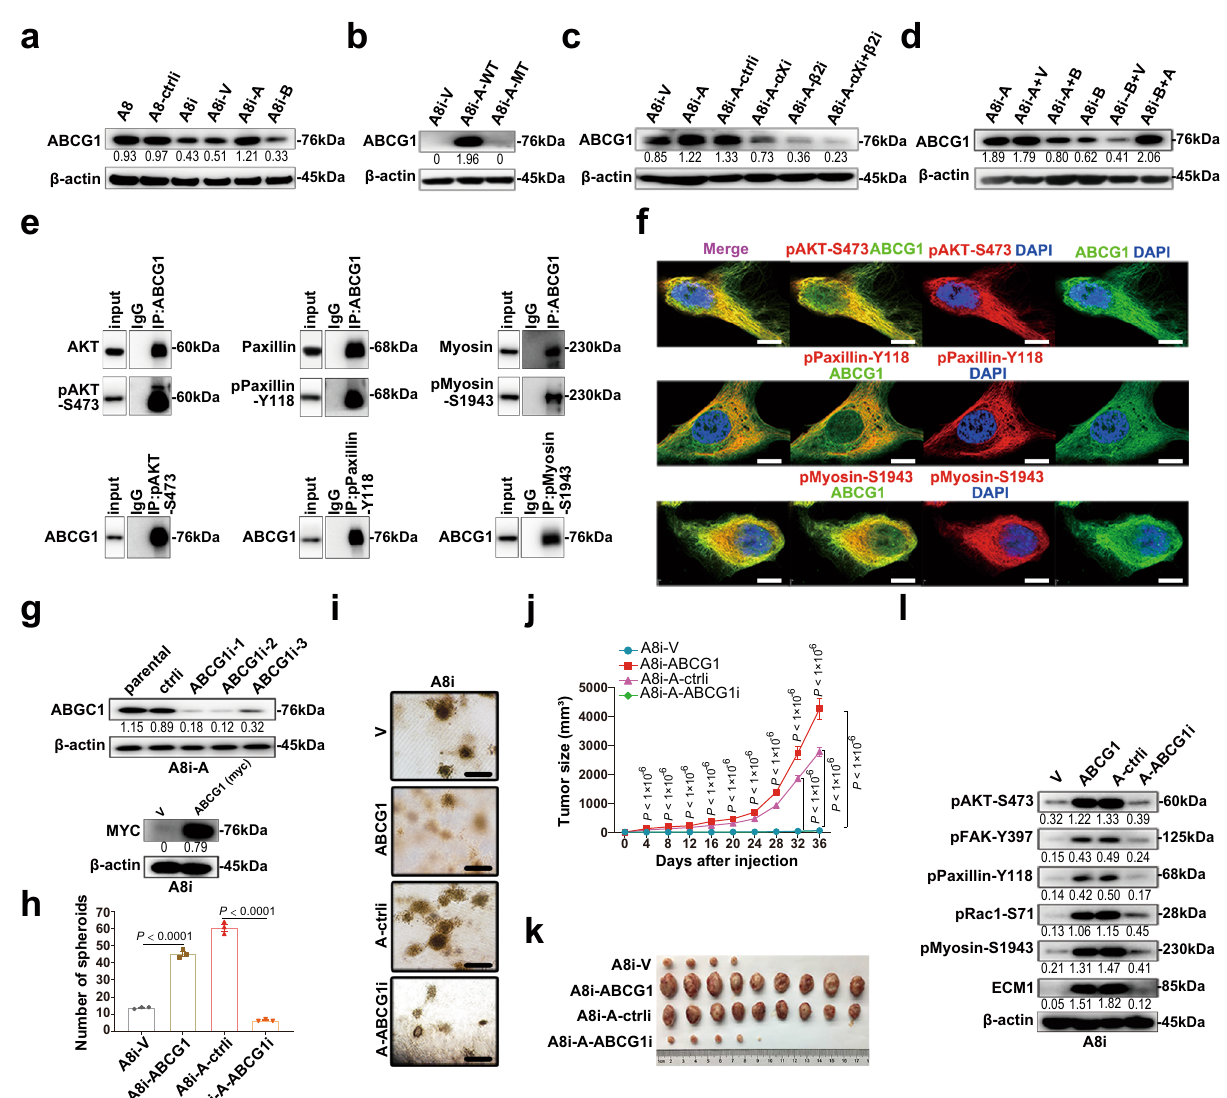
Fig. 6 ABCG1 mediates ECM1a-induced cellular signaling and tumorigenesis. Detection of ABCG1 protein expression by WB analysis in ECM1-silenced/ overexpressing cells ( a ), in ECM1a-WT/ECM1a-MT-expressing cells ( b ), in integrin α X β 2-silenced cells ( c ), and in ECM1b- or ECM1a-cross-transfected cells ( d ). Direct binding and colocalization between ABCG1 and AKT/pAKT, paxillin/pPaxillin, or myosin/pMyosin as detected by co-IP/WB analysis ( e ) and IF ( f , bars = 10 μ m). Stable silencing or overexpression of ABCG1 ( g ) inhibited or promoted the number ( h , data are presented as mean ± SD, n = 3 biologically independent repeats, two-tailed t -test) and growth ( i , bars = 400 μ m) of 3D culture spheroids, xenograft tumor growth ( j , data are presented as mean ± SD, n = 9v9 mice, two-tailed t -test) and tumor tissues ( k ) in nine mice injected with related cells, and cellular signaling molecules associated with ECM1a and integrin α X β 2 ( l